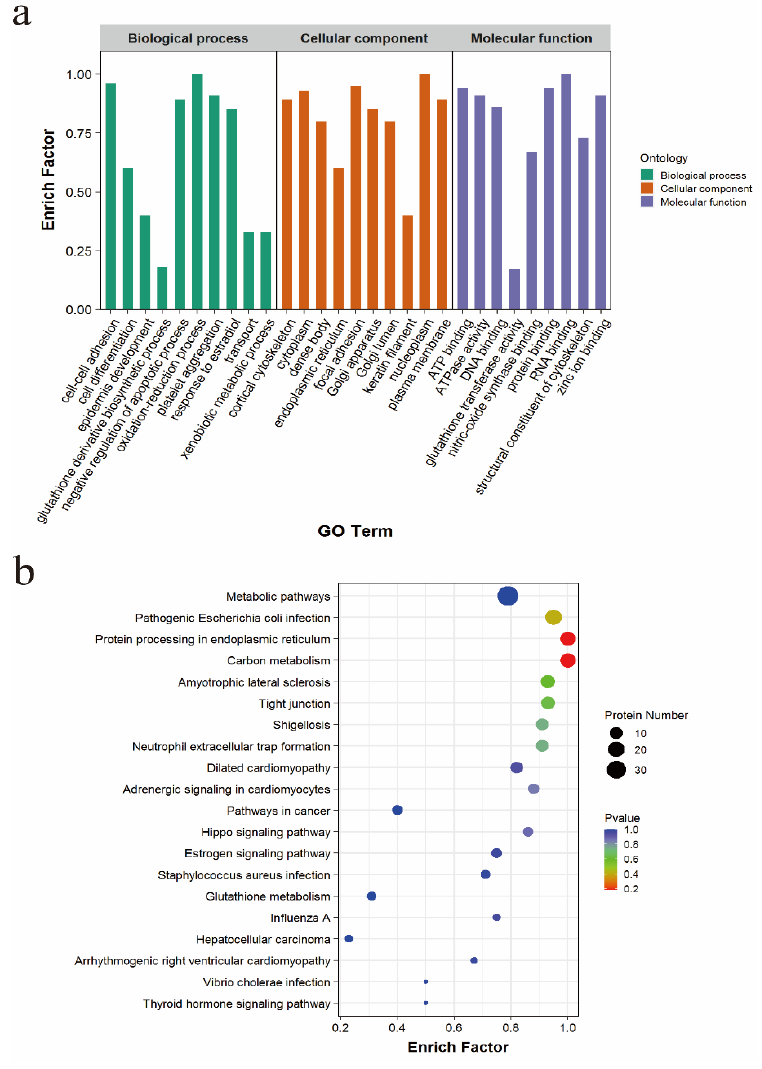
Figure 3. Enrichment analysis. ( a ) GO enrichment analysis of TSSK4-interacting protein. ( b ) KEGG enrichment analysis of the TSSK4-interacting protein.